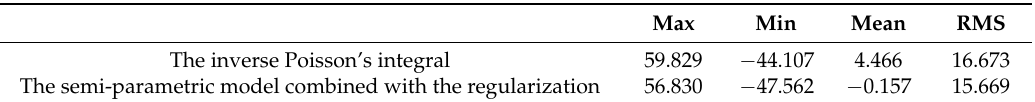
Table 7. The statistics of the differences between the downward continued values (from 5.5 km to 0 km) and the original values in the Tibetan Plateau